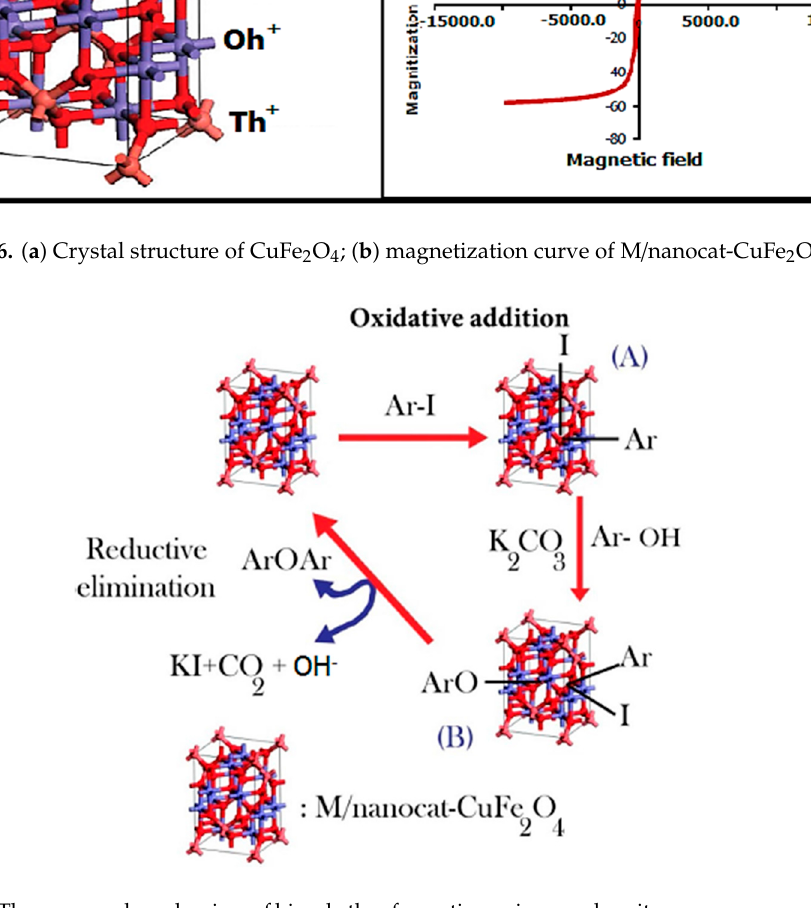
Scheme 16. The proposed mechanism of biaryl ether formation using maghemite-copper